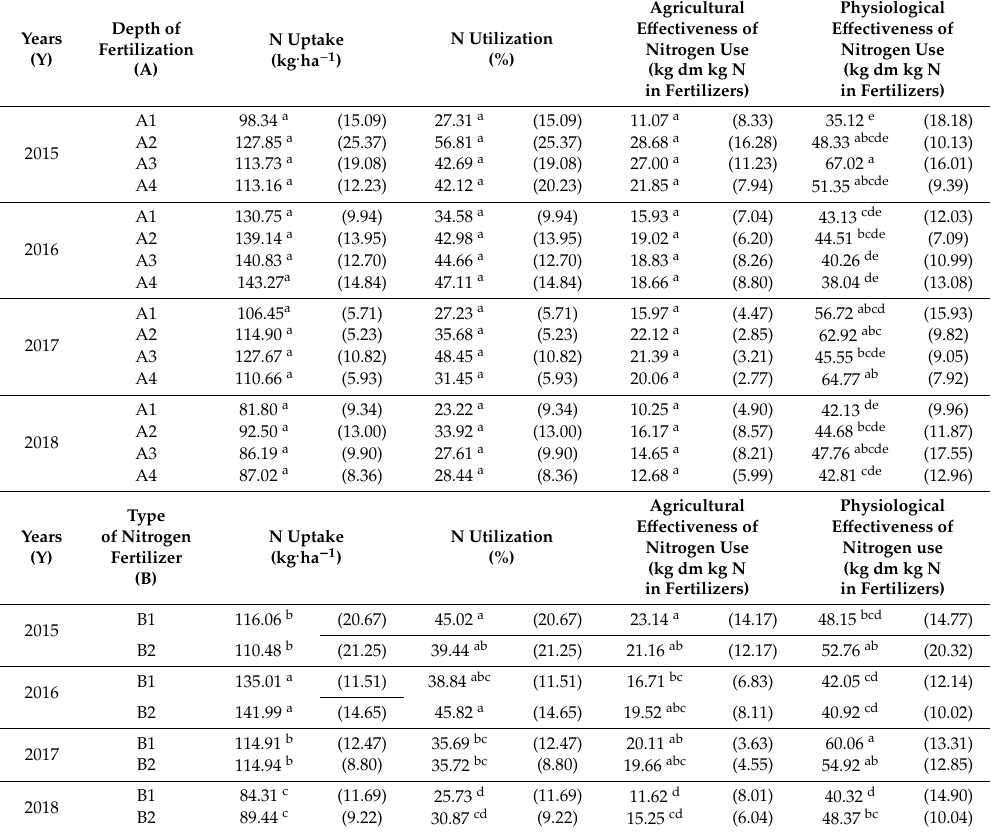
Table 5. Mean values and standard deviations (in brackets) for combinations Y A, Y B and Y